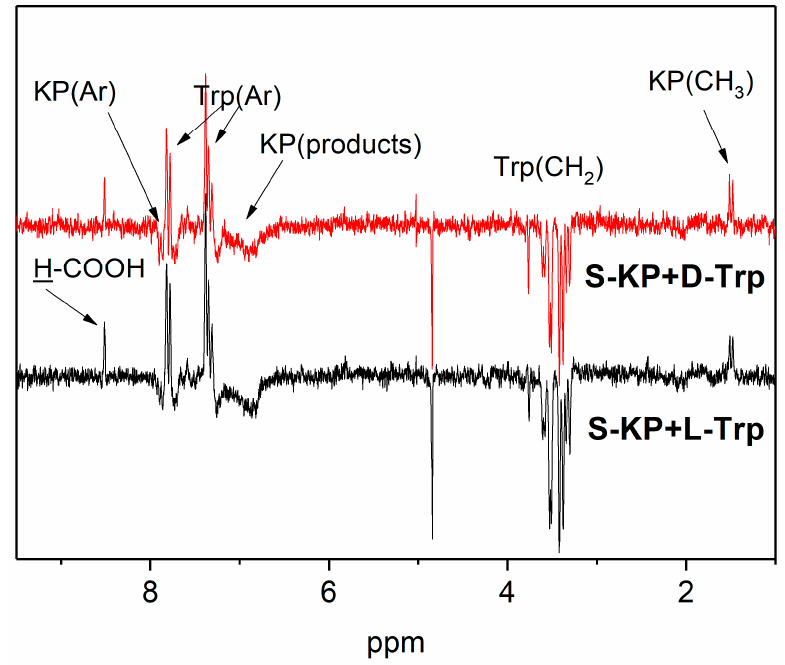
Figure 4. CIDNP spectra detected during photolysis of 2 mM KP in the presence of 4 mM L- and D- tryptophan in PBS at pH 7.4. D-tryptophan in PBS at pH